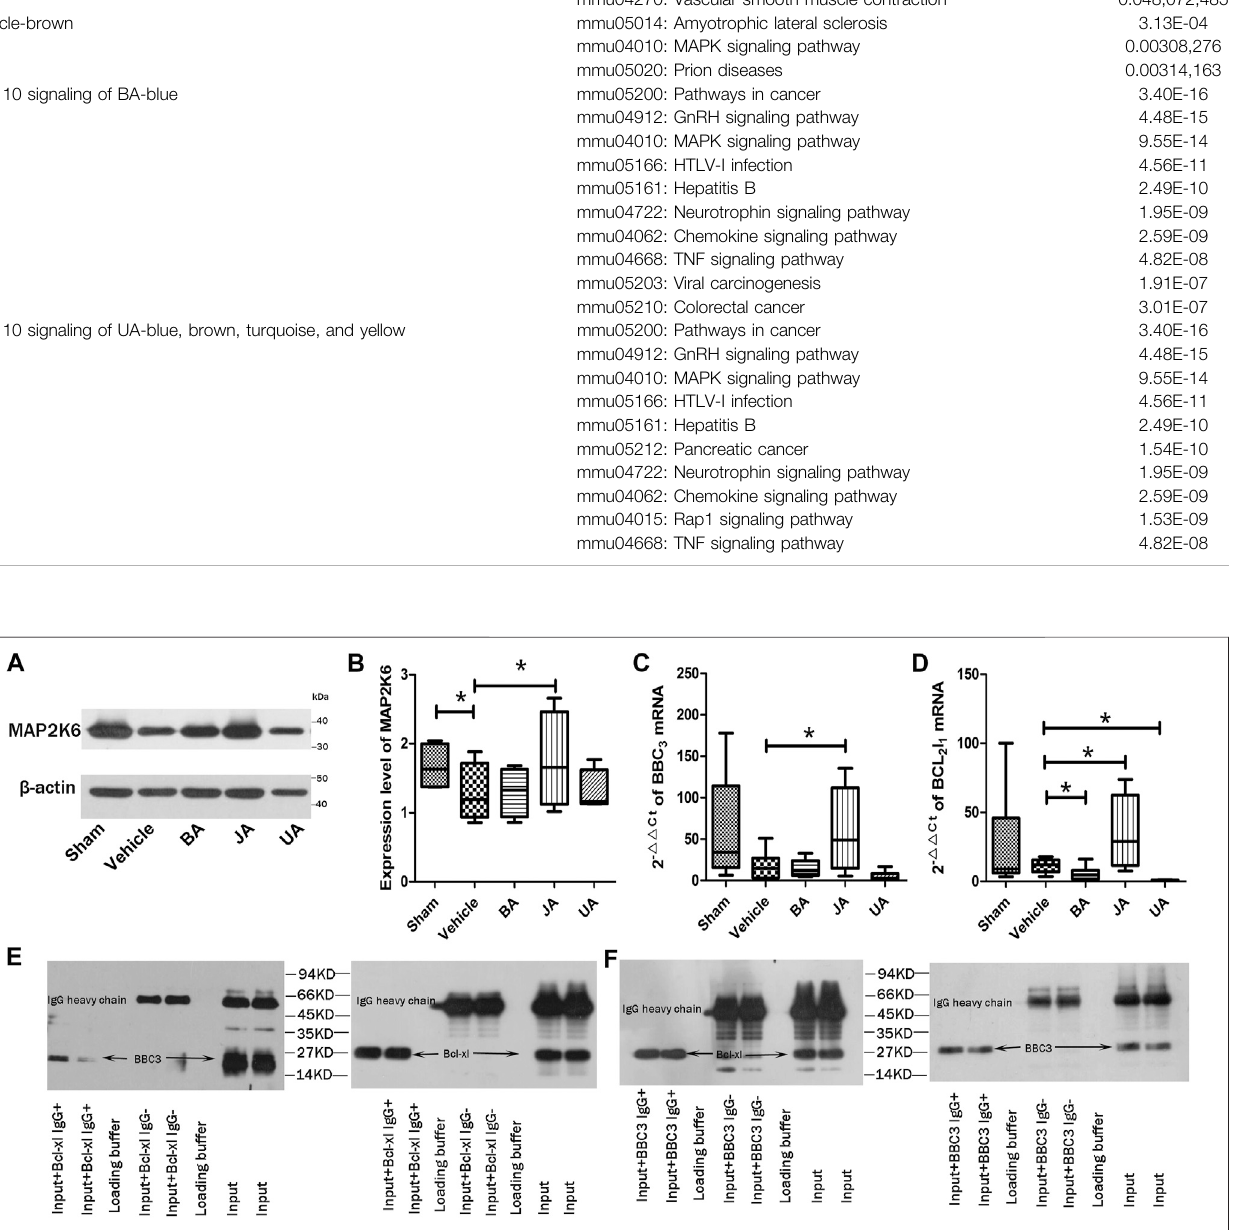
Frontiers in Pharmacology |